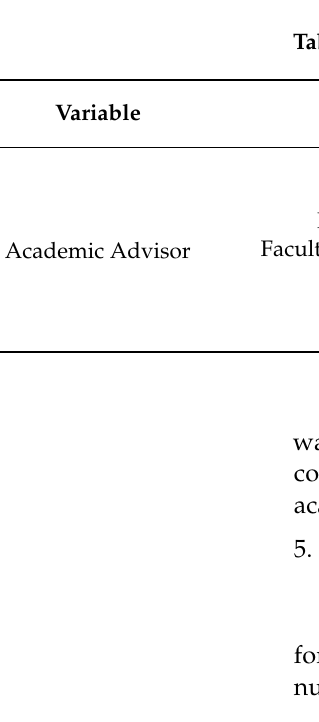
Table 21. Descriptive statistics of study variables by number of approved academic